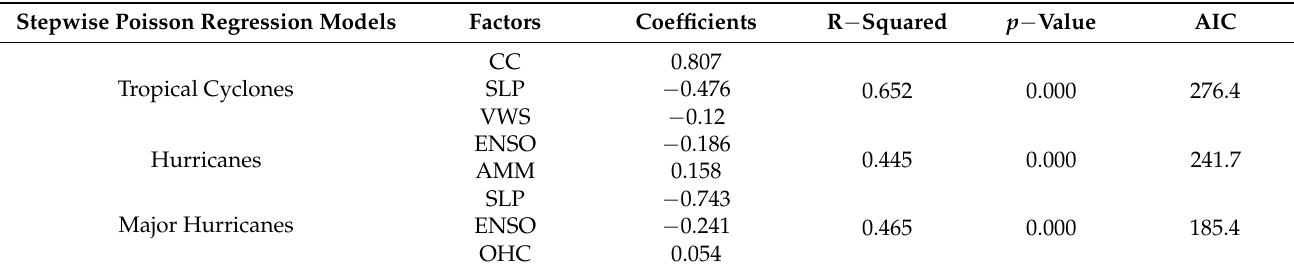
Table 2. Stepwise multivariate Poisson regression model